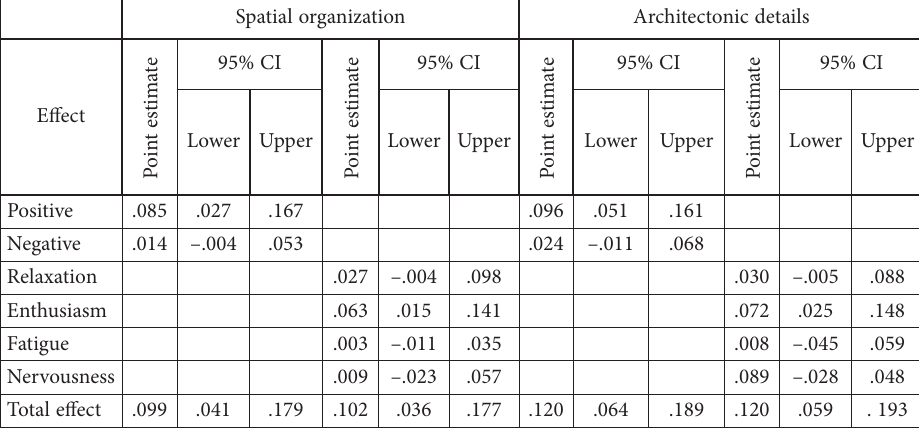
Sample size = 181.